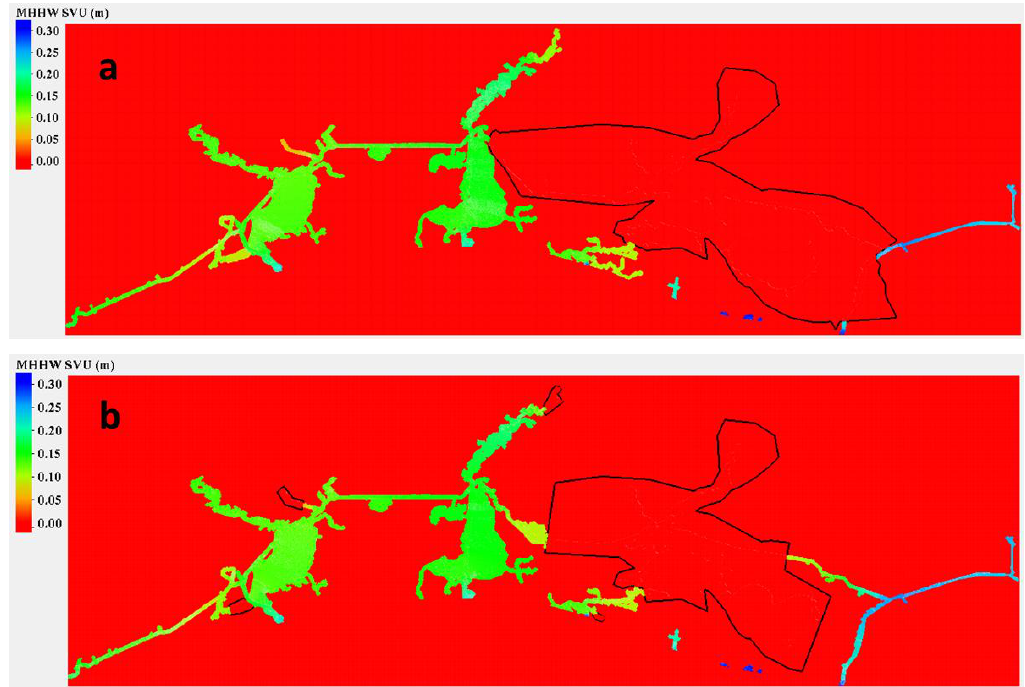
Figure 14. An example of the marine grid population for the modeled MHHW after the SVU interpolation in the western LA coastal region by using the non-tidal polygons before ( a ) and after ( b ) the upgrade.